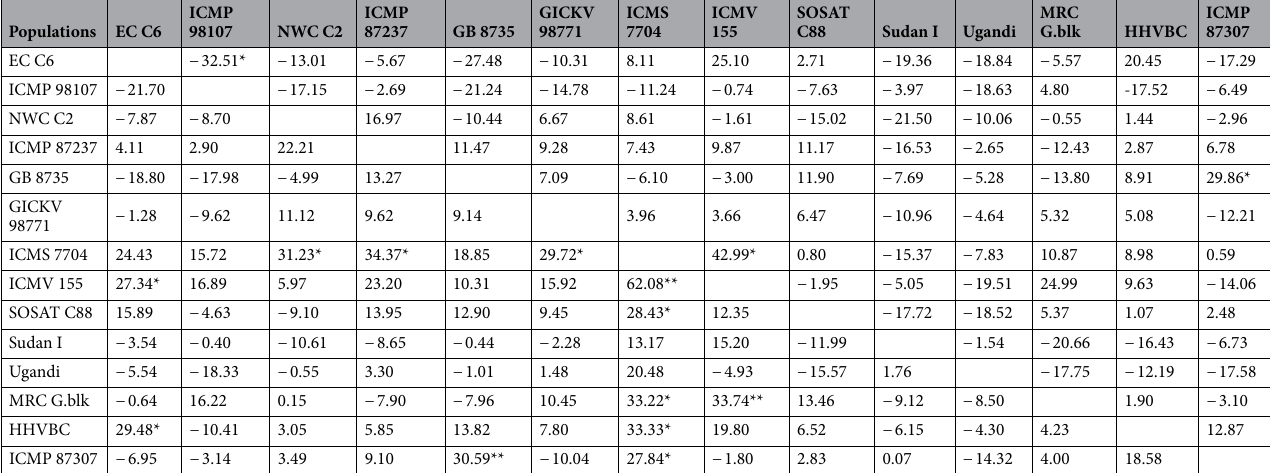
Table 7. Panmictic better parent heterosis (above diagonal) and panmictic mid-parent heterosis (below diagonal) of 91 pearl millet population hybrids across three locations. *, **Significant at 0.05 and 0.01 levels of probability,